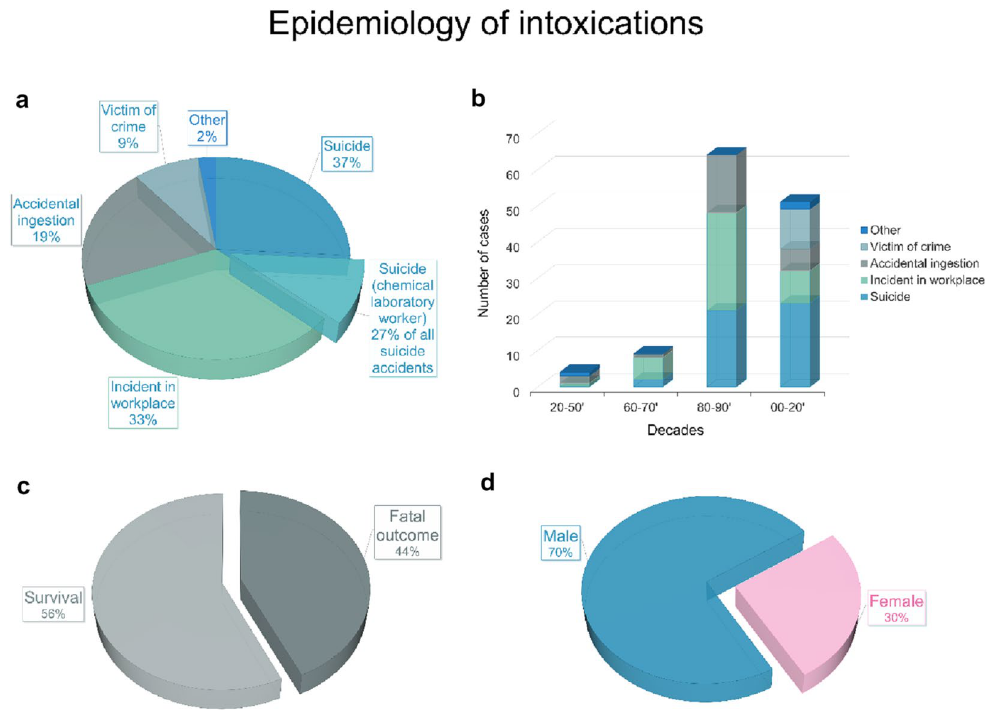
Figure 1. Epidemiology of sodium azide intoxications ( a ) circumstances of exposures; ( b ) exposition between 1920 and 2020 divided into decades; ( c ) outcome of poisoning; ( d ) the relationship between the number of men and women committing suicide by sodium azide